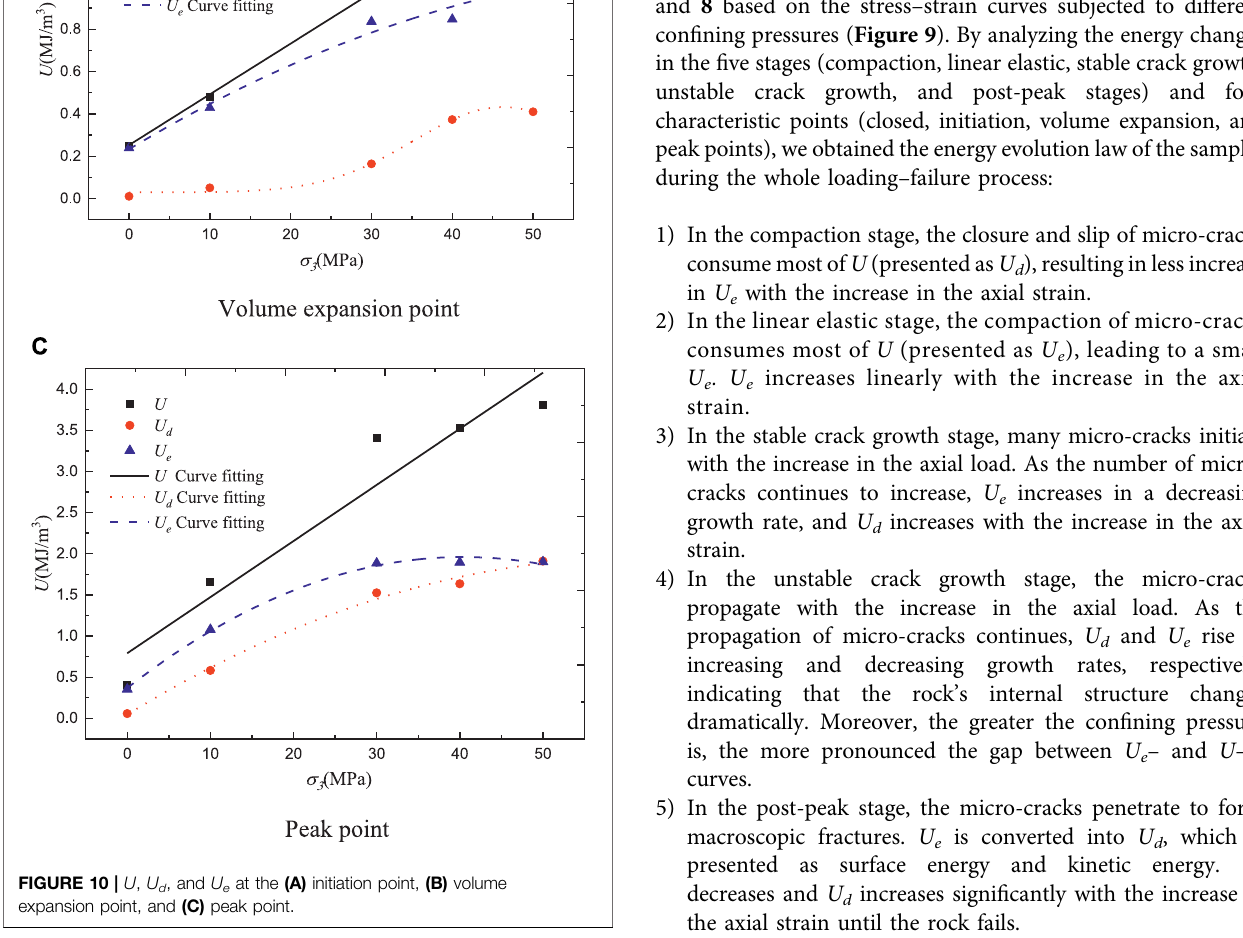
Frontiers in Environmental Science |